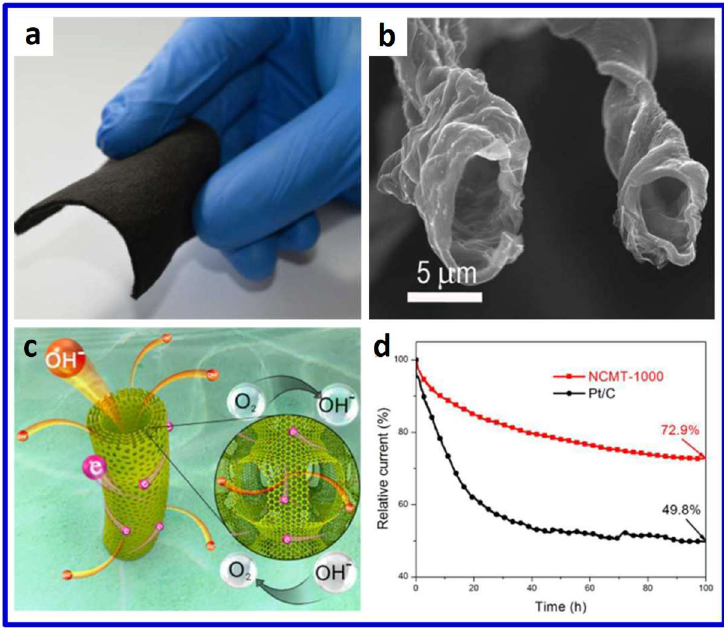
Figure 11. ( a ) Optical and ( b ) SEM images of NCMT-1000; ( c ) Schematic illustration showing the catalysis process on NCMT-1000; ( d ) Stability evaluation of NCMT-1000 and Pt/C tested by the chronamperometric responses. Reproduced from [134], Copyright 2016, The Royal Society of Chemistry.